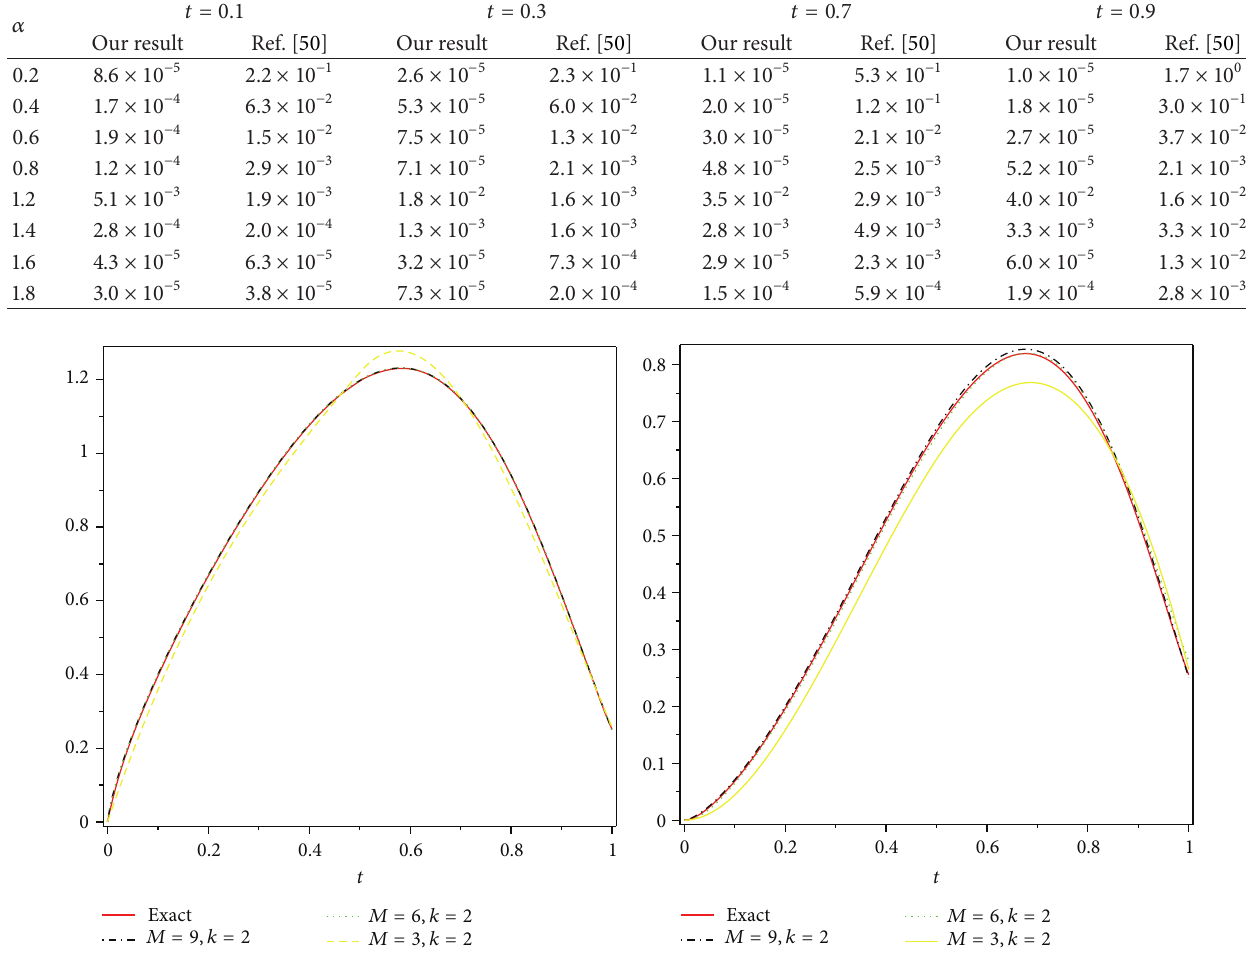
Table 1: Comparison of absolute error in 𝑦(𝑡) in [50] and obtained using our method for Example 1.